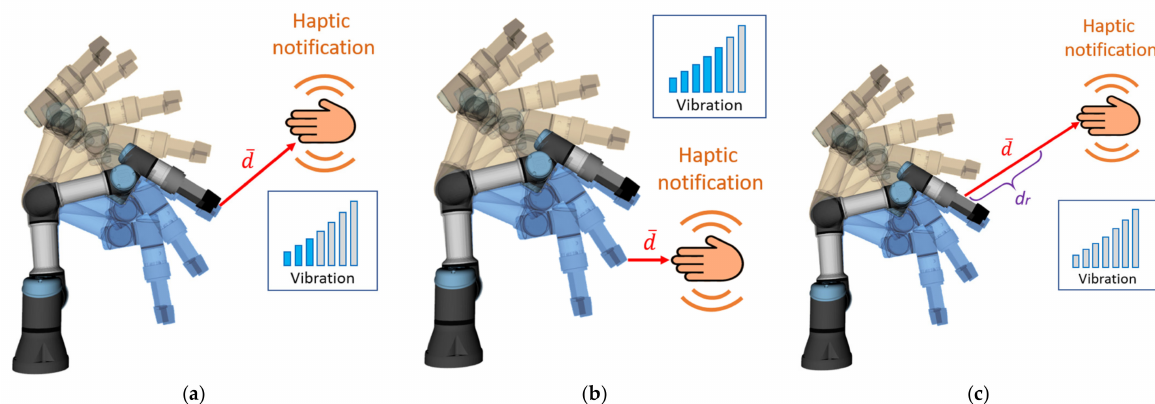
Figure 2. Illustration depicting the principle of distance notification: ( a , b ) vibration intensity is proportional to the distance to the closes point of the robot body in any timestep of the future trajectory; ( c ) distance notification is not active when the hand is further than the safe distance (reaction distance d r